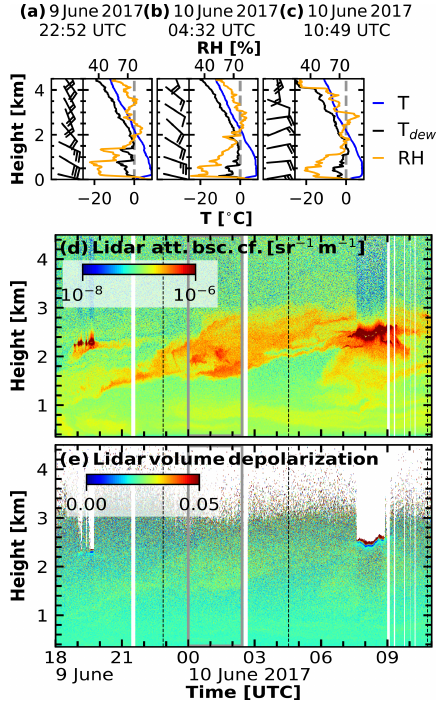
Figure 12. (a–c) Same as Fig. 9 but for 9 June 2017 18:00UTC– 10 June 2017 11:00UTC up to 4.5km height. (d, e) Measurements from Polly XT between 9 June 2017 18:00UTC and 10 June 2017 11:00UTC. In panels (d) and (e) , the 1064nm attenuated backscat- ter coefficient and the 532nm volume depolarization are shown, re- spectively. The black dashed lines mark the time of the radiosonde launches as shown in panels (a) – (c) . The grey box indicates the pe- riod used for averaging in Fig.